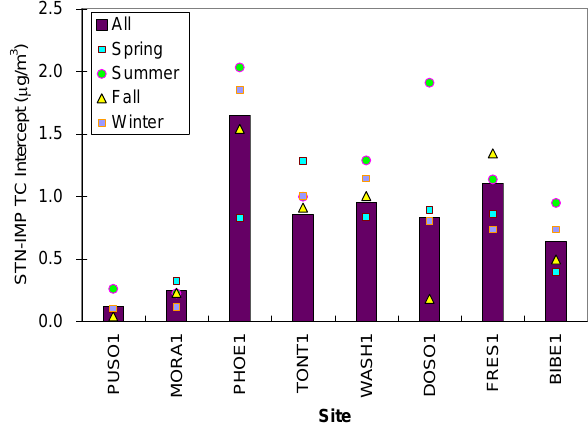
Figure 8. Fig. 8. The uncorrected STN–IMPROVE TC regression intercept for the entire data set and seasonally-segregated data from the eight collocated sites. Site names are PUSO1 (Seattle, WA); MORA1 (Mount Rainier, WA)]; PHOE1 ([Phoenix, AZ); TONT1